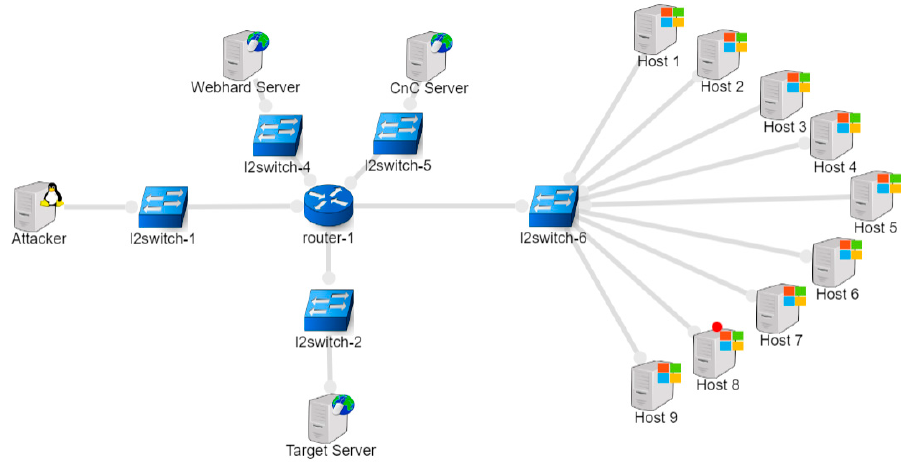
Figure 11. Small real-world network based on virtual machines.